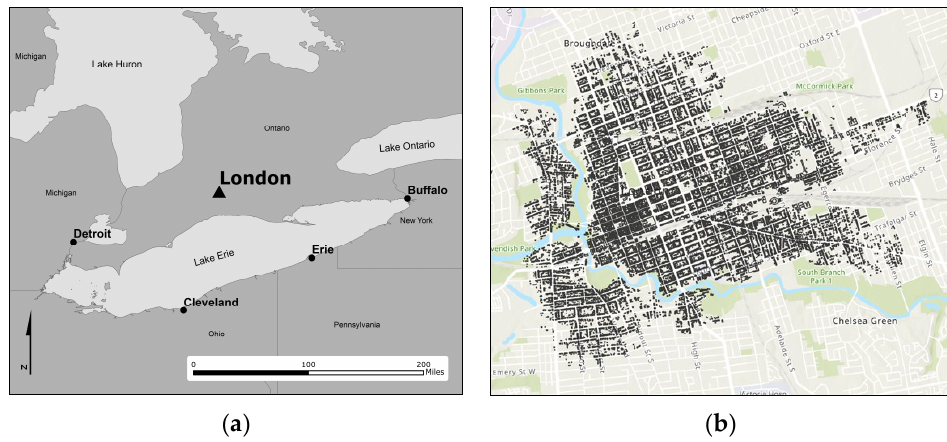
Figure 1. The project study area is London, Ontario, found in the heart of the North American Rust Belt (a). The study is focused on the urban portions of London, Ontario across the period 1888 to present (b). Map by author.